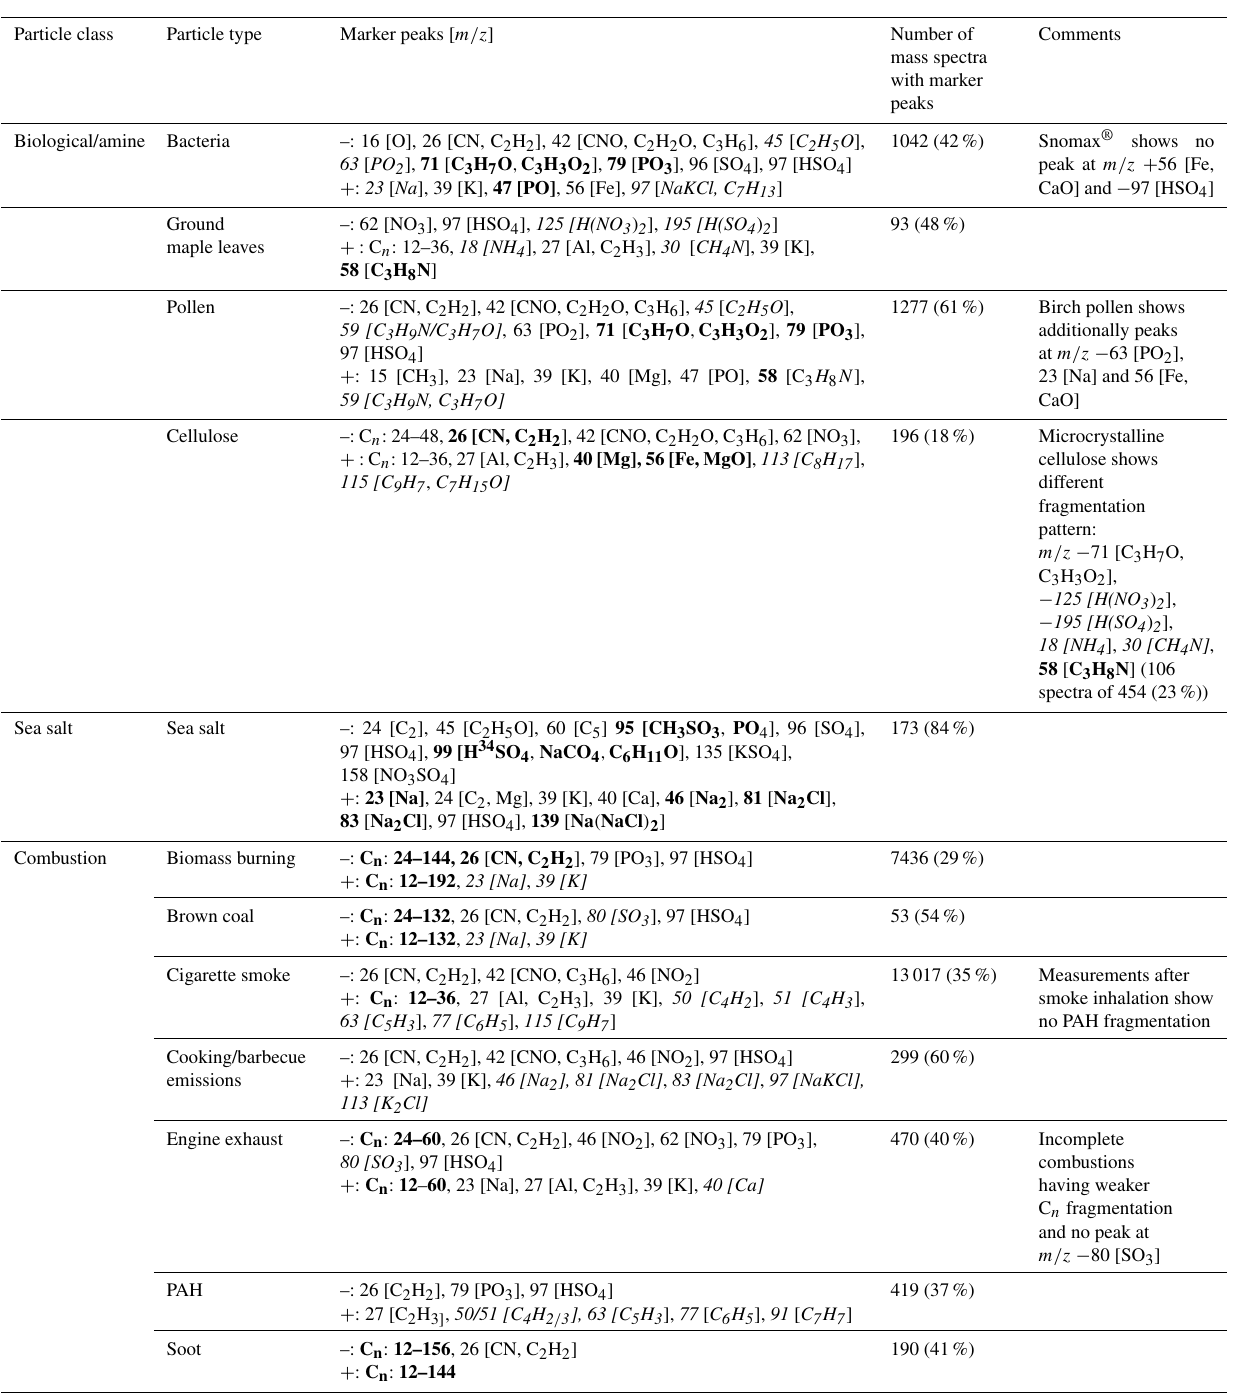
Table 2. Overview of the different measured particle classes from primary biological, sea salt, combustion and mineral sources with their characteristic marker peaks, along with number and percentage of spectra that include these marker peaks. Peaks marked in bold are the characteristic marker peaks of each particle class; peaks marked in italic show the characteristic marker peaks of one particle type. “–” designates anion spectra and “ + ” cation